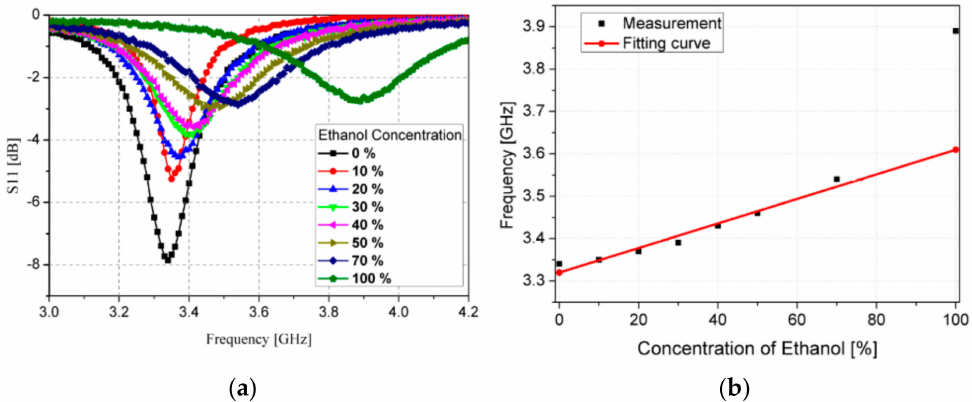
Figure 9. The measured reflectance S11 for the various concentration of ethanol in the deionized water ( a ) and the changing of the resonant frequency for different ethanol-deionized water solutions ( b ) [97].